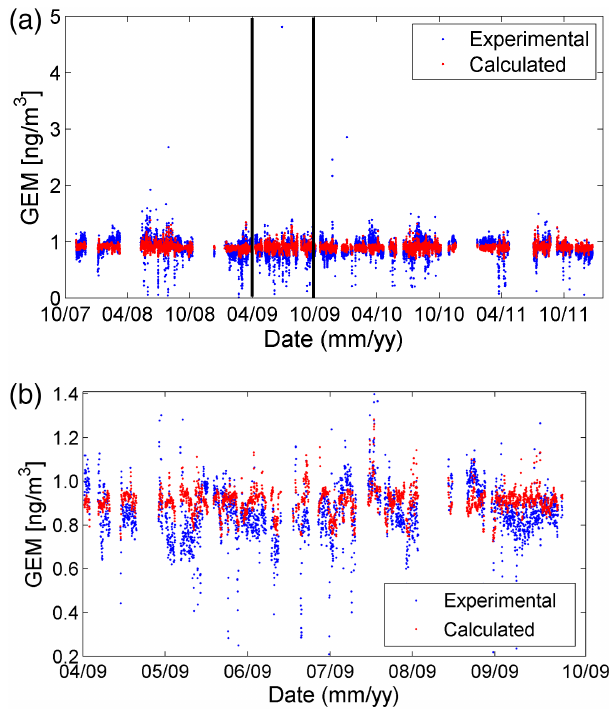
Figure 8. (a) Measured GEM (blue) and calculated GEM concen- trations using the MLR Eq. (1) (red) for the entire sampling pe- riod. The two vertical black lines in (a) indicate a period that was enlarged in (b) to indicate more detailed differences between the measured and calculated GEM